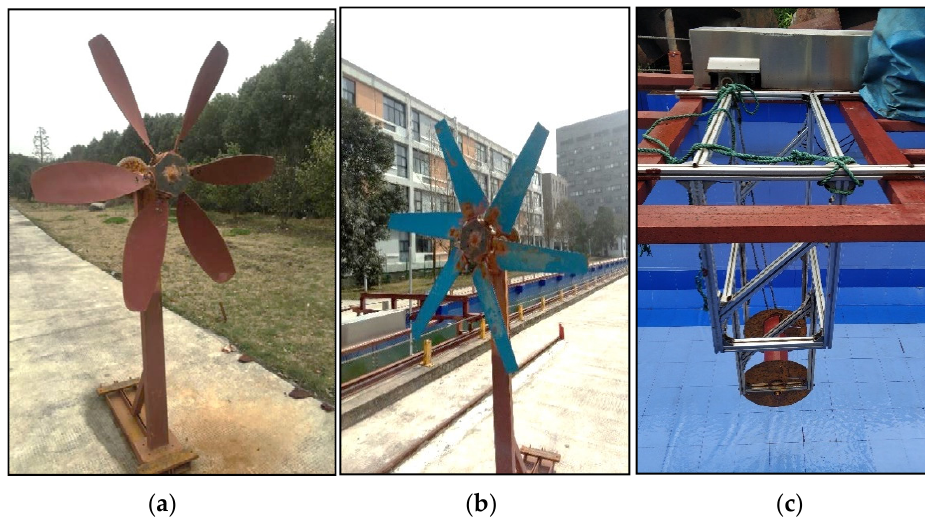
Figure 6. Physical image of hydraulic turbine model: ( a ) thin-walled airfoil, ( b ) NACA airfoil, ( c ) Savonius type. ( c ) Savonius